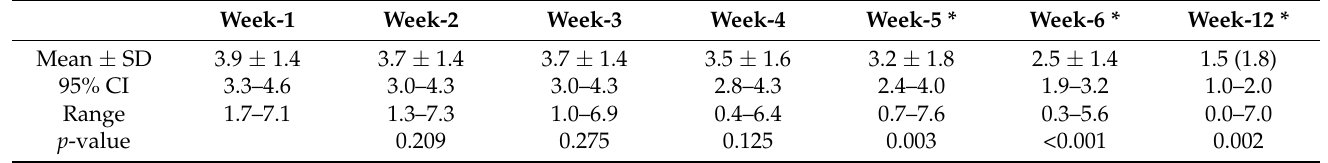
Table 1. Weekly pain scores during the intervention and at the 12-week follow up